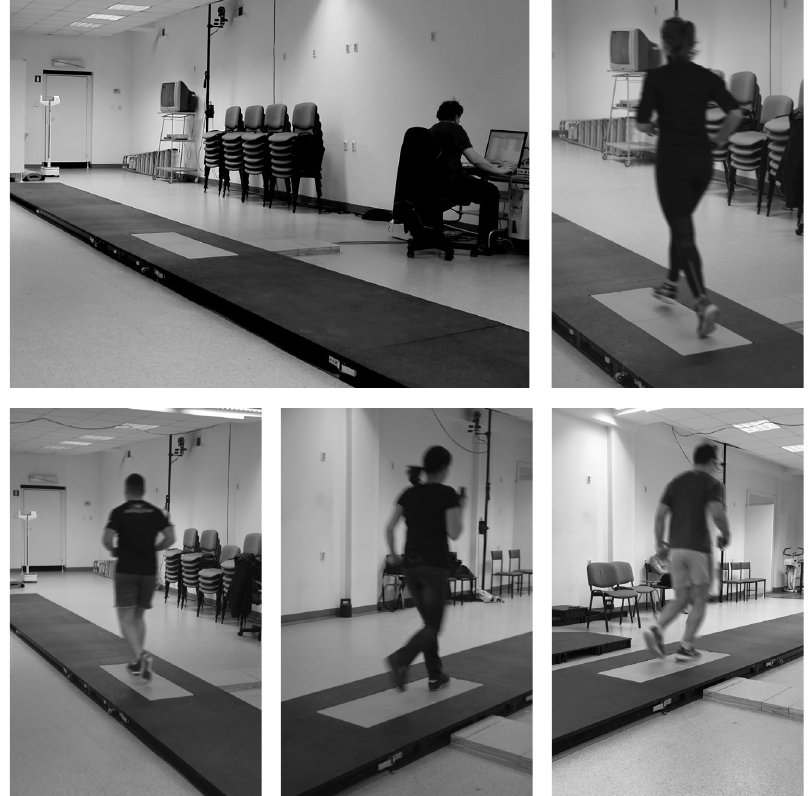
Figure 3. Laboratory tests: general view of the walkway with centrally placed force plates, examples of running